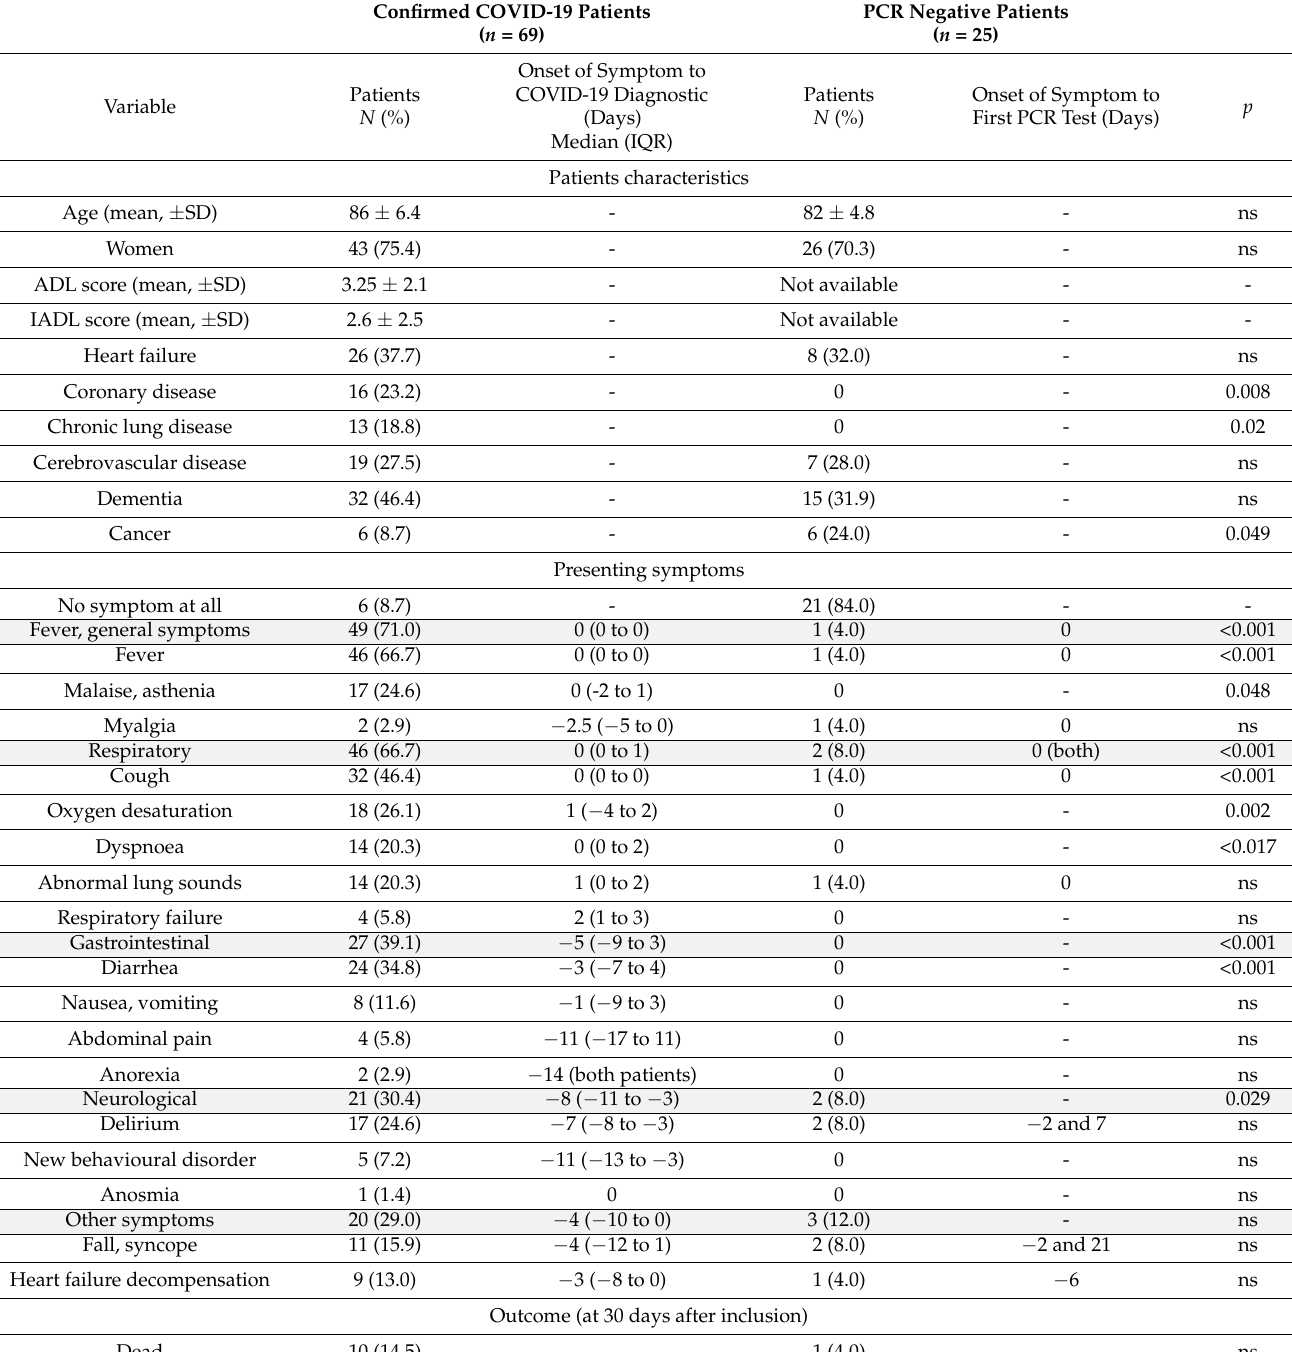
Table 1. Signs and symptoms of COVID-19 in included